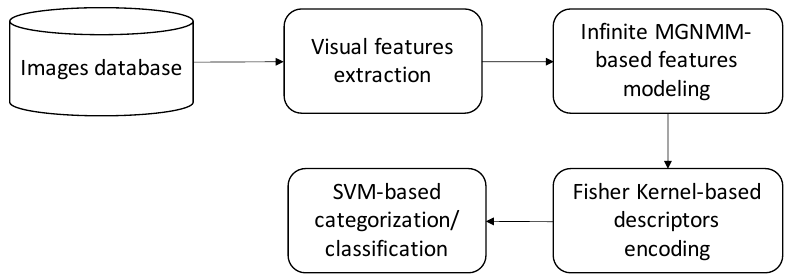
Figure 1. The pipeline of the proposed method. First, robust invariant visual features are extracted from each image. Then, these features are modelled using an infinite multivariate generalized Normal mixture model. The next step consists of encoding them using Fisher vectors to obtain effective descriptors. Finally, an SVM classifier is applied for categorization and classification